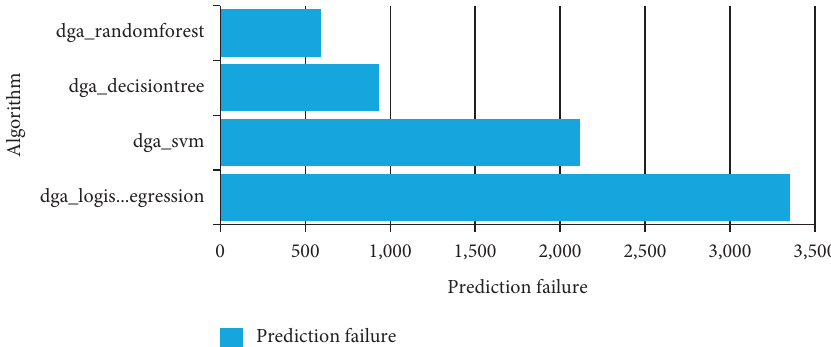
Figure 18: Prediction error rate diagram for DGA botnet detection.